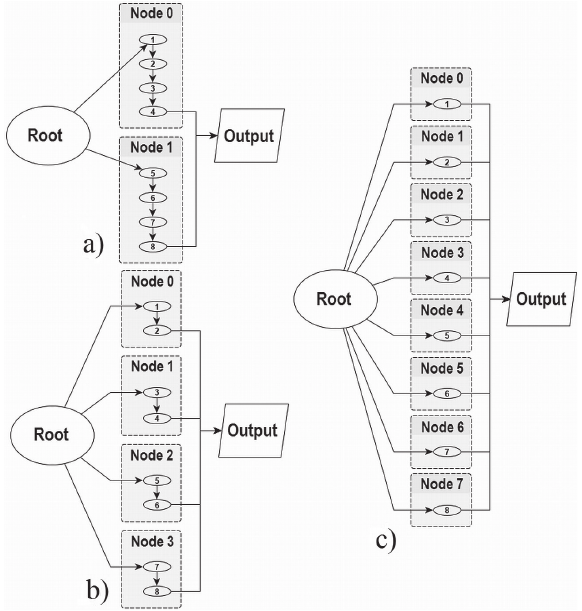
Figure 3. Distribution of octants by computation nodes: a) two nodes; b) four nodes; c) eight